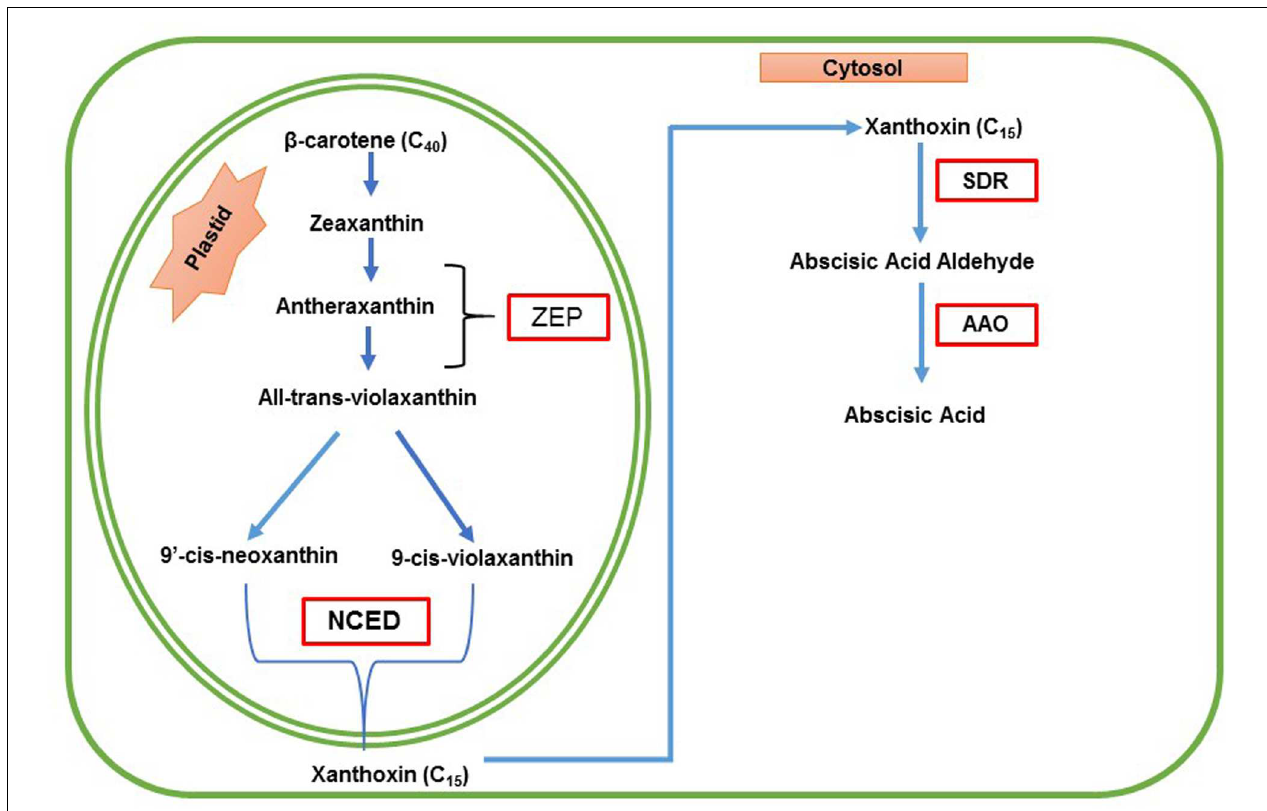
FIGURE 1 | Schematic representation of biosynthesis of ABA in plants. ABA is derived from β -carotene (C 40 ) through an oxidative cleavage reaction in plastids. The first step of ABA biosynthesis pathway is the conversion of zeaxanthin and antheraxanthin to all trans-violaxanthin, which will be catalyzed by zeaxanthin epoxidase (ZEP). Antheraxanthin is the intermediate product. All– trans -violaxanthin is converted to 9- cis -violaxanthin or 9 (cid:48) - cis -neoxanthin by the 9- cis -epoxy carotenoid dioxygenase (NCED), which yields a C15 intermediate product called xanthoxin. Then the product xanthoxin is exported to the cytosol (Nambara and Marion-Poll, 2005) where xanthoxin is converted to ABA. Xanthoxin is then converted into ABA by two enzymatic reactions. Finally, xanthoxin is converted to an ABA aldehyde by the enzyme, short-chain alcohol dehydrogenase/reductase (SDR), and then oxidation of the abscisic aldehyde to ABA is catalyzed by the abscisic aldehyde oxidase (AAO). (Modified from, Taylor et al., 2000; Finkelstein and Rock, 2002; Tuteja, 2007; Mehrotra et al.,